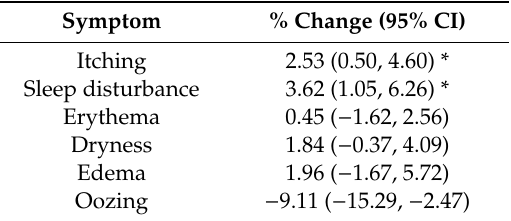
Table 5. E ff ects of AQM-NO 2 on each AD symptom (0–3 km) a